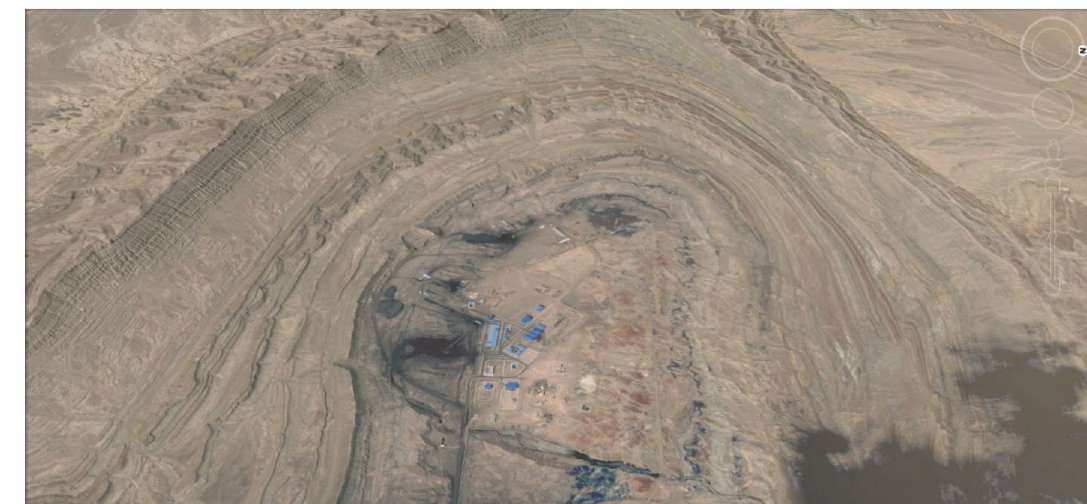
Figure 2. Location and structural geology of the Tabas mine region, taken from GoogleEarth 32